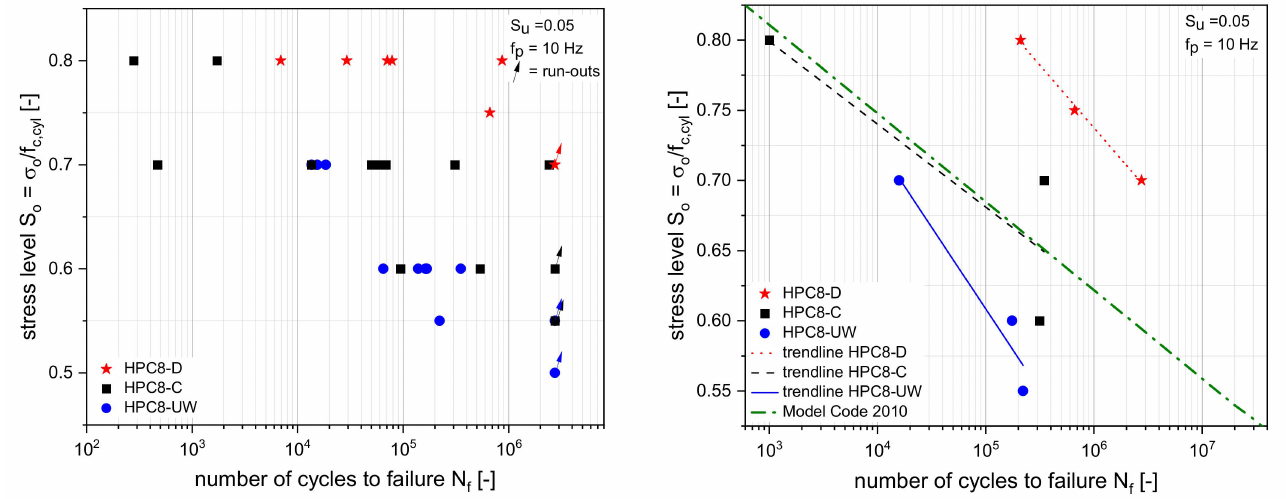
Figure 6. Number of cycles to failure of HPC8 ( left ). Average values of the number of cycles to failure and the corresponding trend lines of HPC8 ( right ).